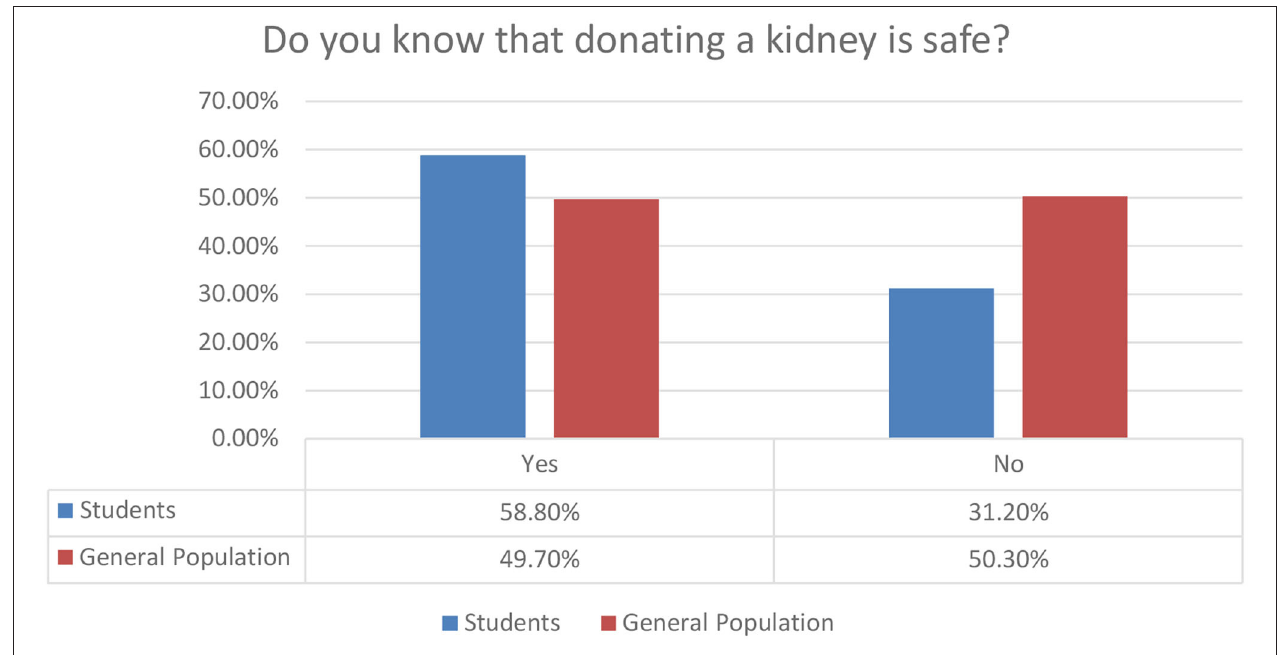
FIGURE 4 | Perception on safety for kidney